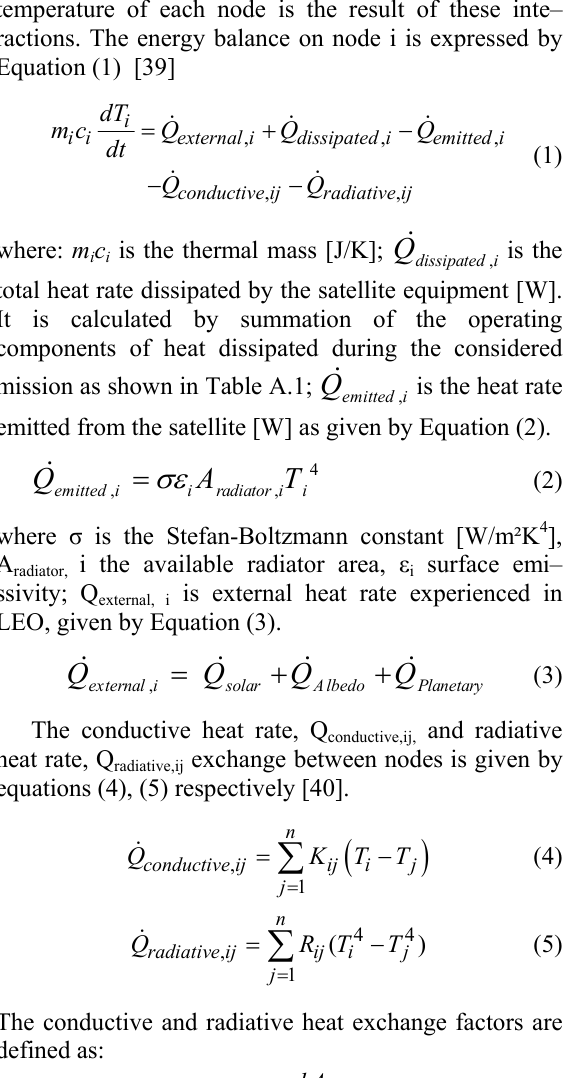
Fig. 2 Internal view of ESEO satellite adapted from [25] The mission was based on sun-synchronous orbit with an altitude of 520 km and an inclination of 97.48° with Local Time of Ascending Node (LTAN) 10:30. Satellite systems/components are given in Table